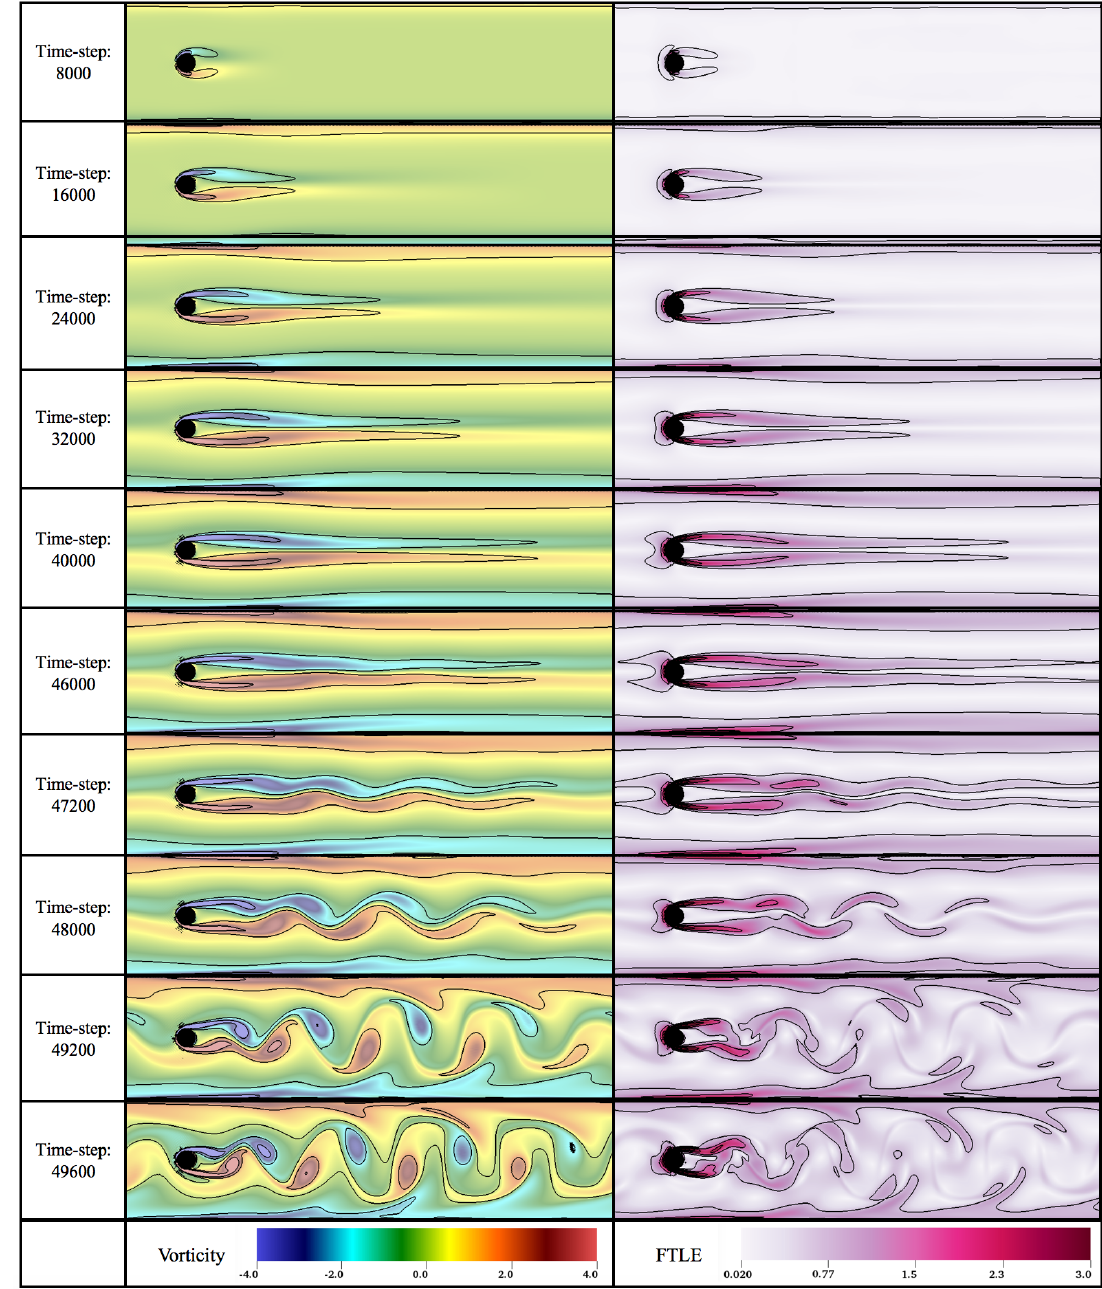
Figure 35. Illustrations depicting the flow’s evolution to vortex shedding using vorticity ( left column ) and finite-time Lyapunov exponent ( right column ) with their contours,